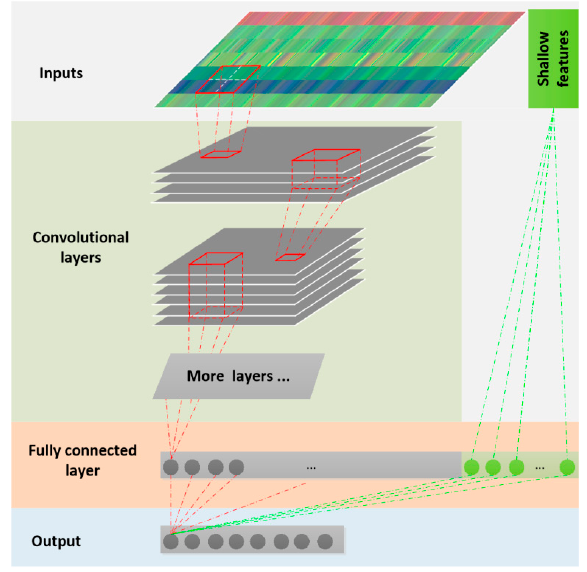
Figure 5. Workflow of deep convolutional neural network (CNN) models.